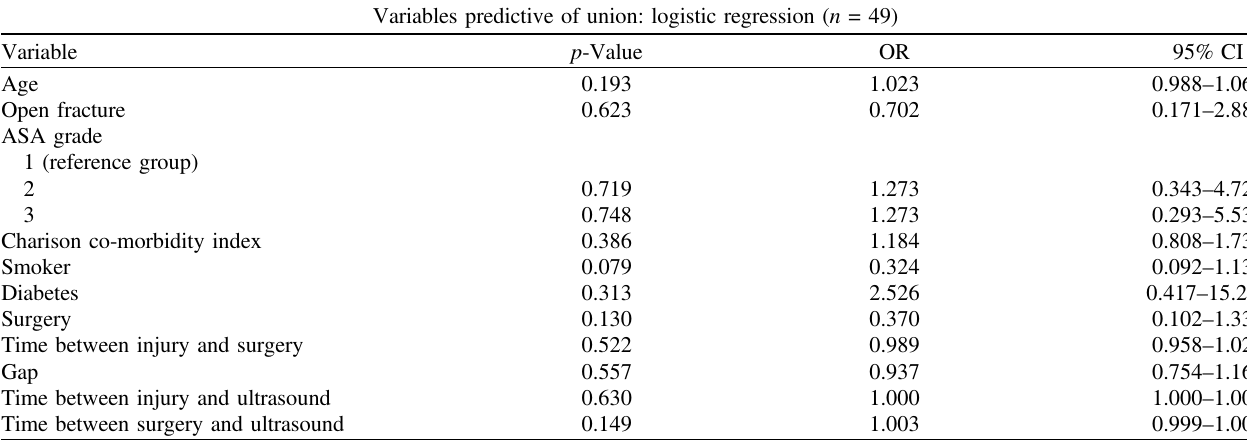
Table 1. Table with statistical comparison of patient characteristics between union and persistent non-union groups revealing no variables of signi fi